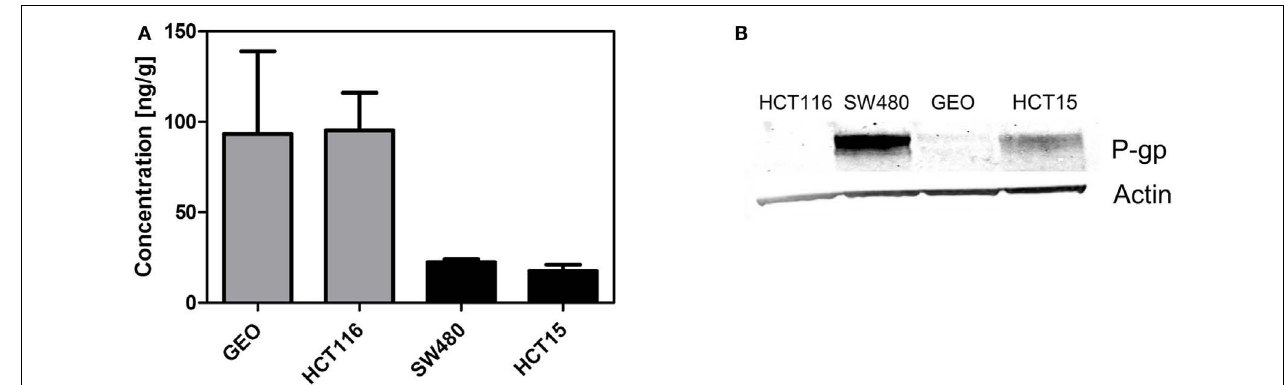
performed to determine the presence or absence of P-gp in tumors. Corresponding with the higher concentrations observed in HCT116 and GEO tumors, no P-gp was detected. And, in the SW480 and HCT15 tumors where lower concentrations of PF-309 were determined, P-gp was detected.